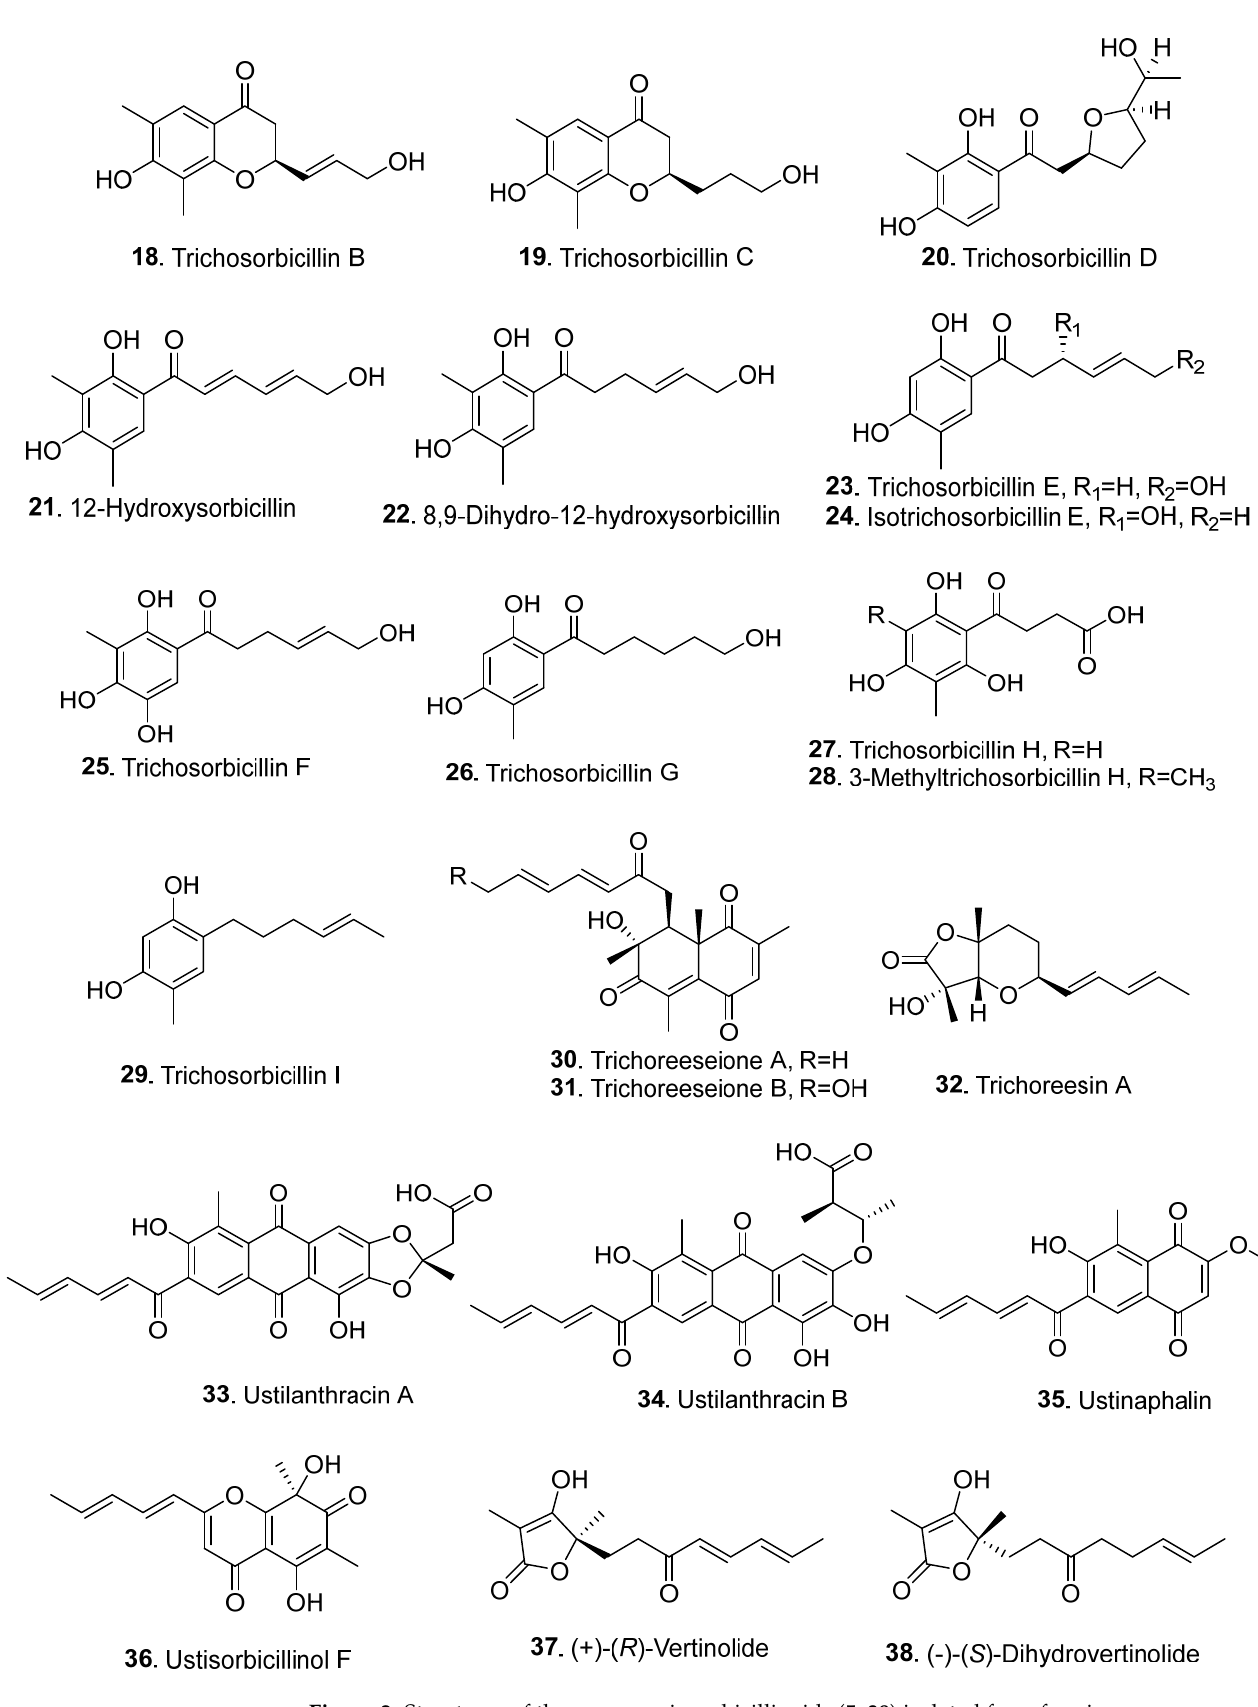
Figure 2. Structures of the monomeric sorbicillinoids ( 5 – 38 ) isolated from fungi.